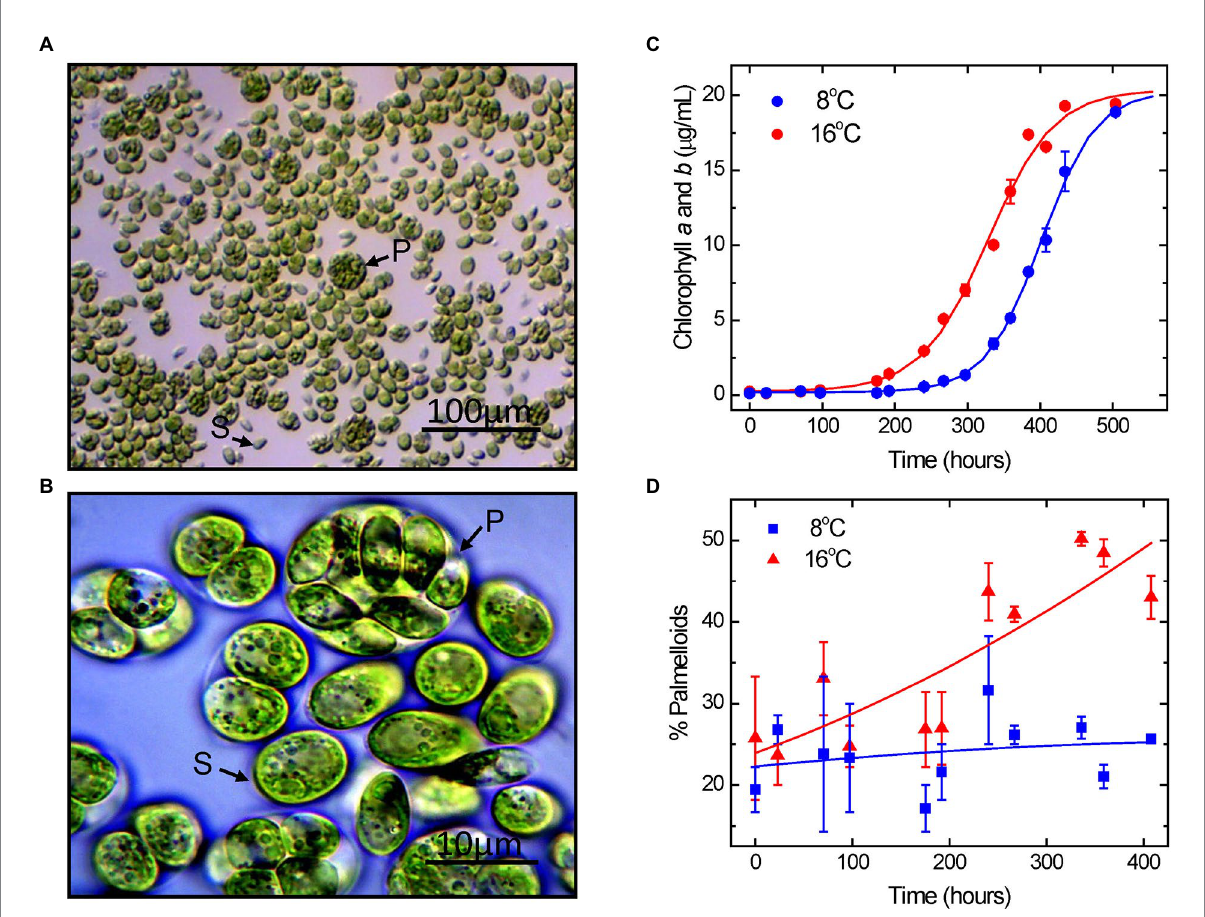
FIGURE 1 Light microscope images of Chlamydomonas priscuii cultures at 100x (A) and 1,000x (B) magnification. Cells exist as motile, flagellated single cells (S) and multicellular palmelloids (P). Growth curves of C. priscuii cells grown under steady-state temperatures of 8 ° C and 16 ° C, as measured by total chlorophyll concentrations (C) . C. priscuii exhibited an exponential growth rate of 0.0986 μ g Chl h − 1 at 8 ° C and 0.0483 μ g Chl h − 1 at 16 ° C. Percentage of cell units present as palmelloids was measured under the same growth temperature regimes (D)